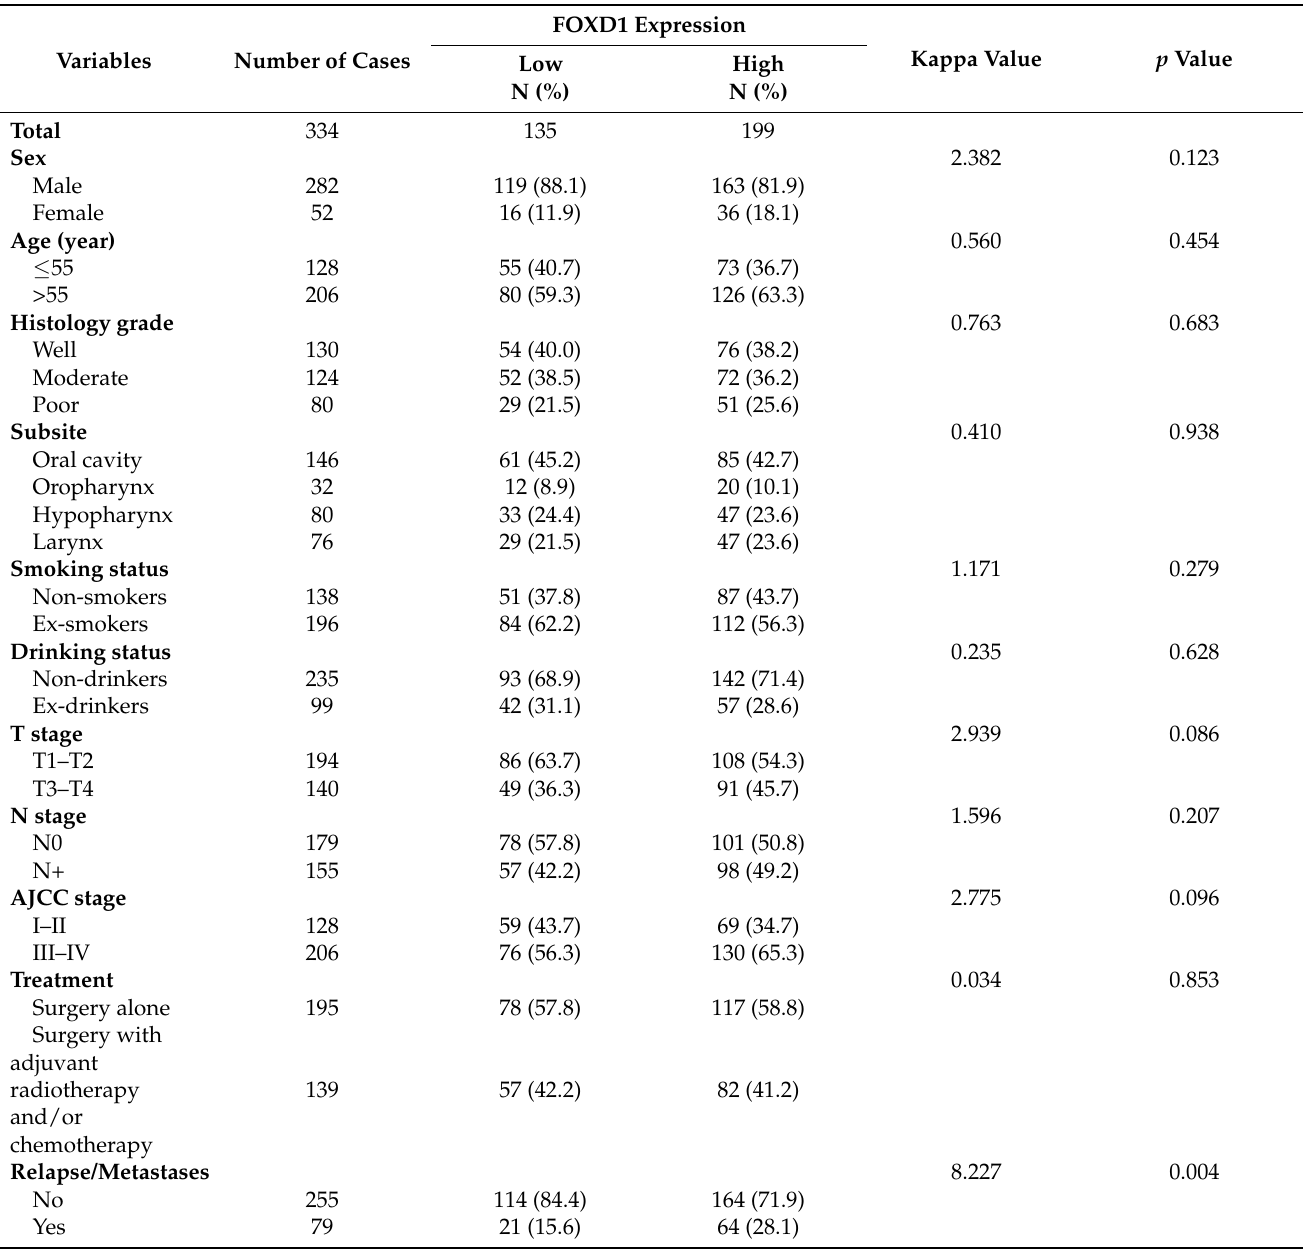
Table 1. Associations between FOXD1 expression level and clinicopathological characteristics of HNSCC